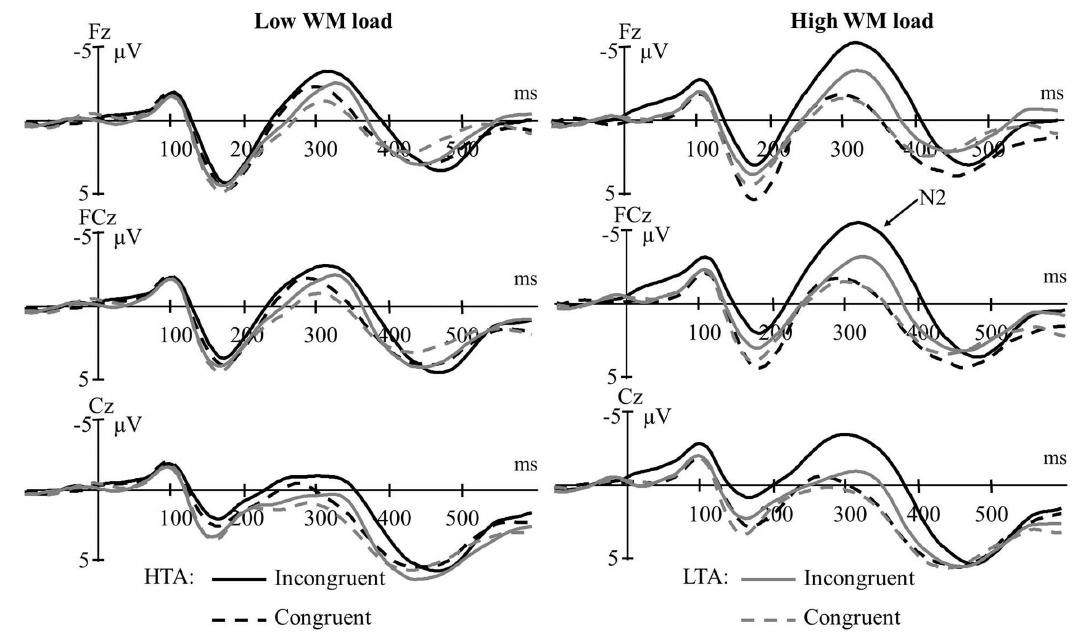
Figure 3. Grand average waveforms for the high-trait-anxious (HTA) and low-trait-anxious (LTA) groups in each condition over Fz, FCz, and Cz sites.